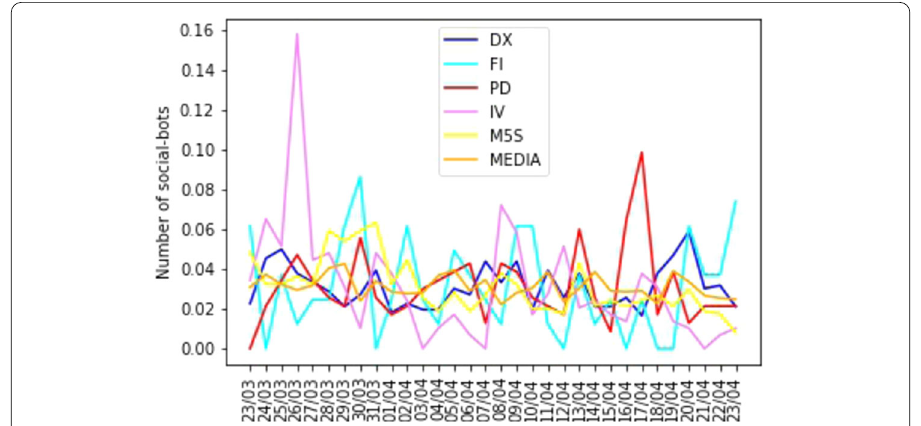
we were able to identify specific topics; for instance, in one sub-community we found many hashtags about immigration (like # migranti , # immigrati , # clan- destini , # alankurdi , # ong 12 ), which has been one of the most discussed politi- cal topics in Italy. Especially during the epidemic some extreme right accounts connected the migration from Northern Africa to the spread of the contagions, without reasonable evidences. There is also a sub-community which contains hashtags of protest against the government, like # governocriminale , # governodel- contagio , # contedimettiti , # contebugiardo and # vogliamovotare . 13 Another pop- ular topic is the European Stability Mechanism (the Italian acronym is MES), which is a European Union agency that provides financial assistance to European countries, in the form of loans or as new capital to banks in difficulty. 14 Indeed, among the most connected hashtags in this community there are also # esm , # mes , # sure , 15 # nomes and # nosure . Violet This communities contains 815 elements and the hashtags with the highest